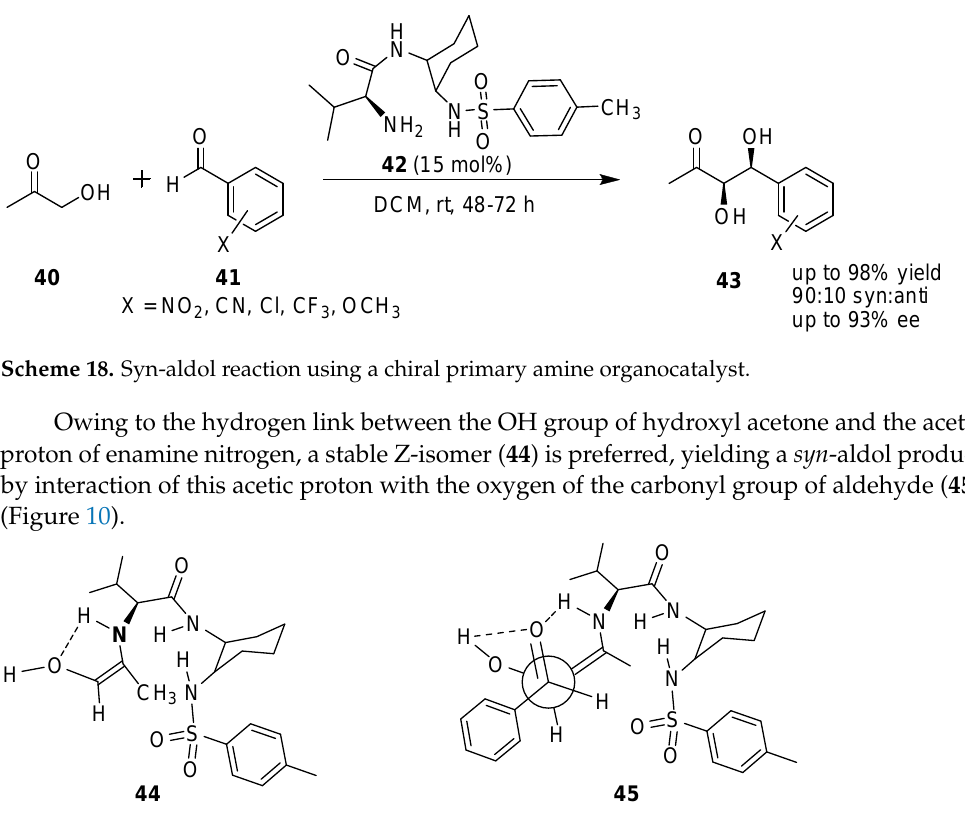
99% dr ) but with low enantioselectivity (up to 52% ee ). According to the authors ’ predic-